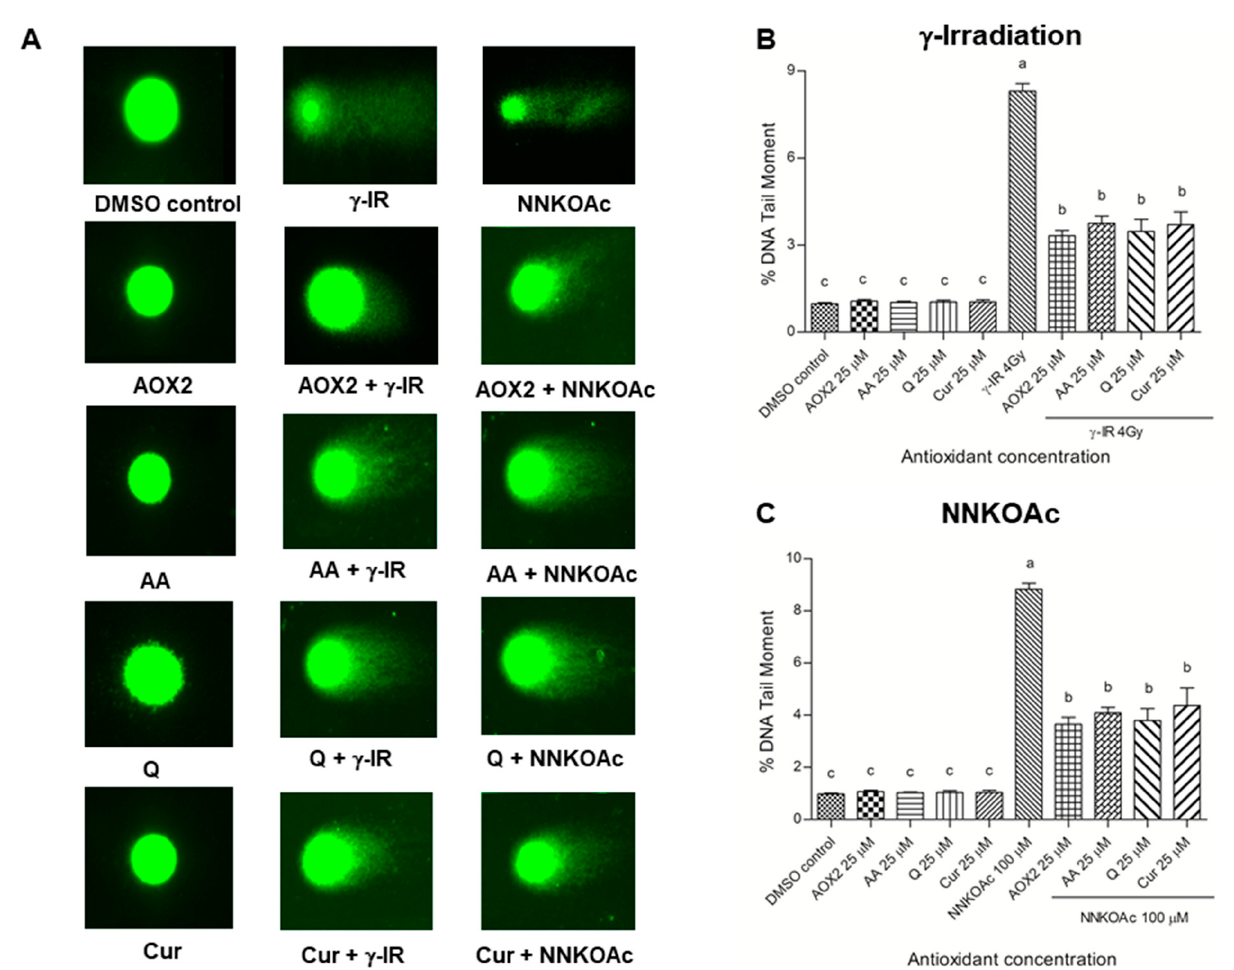
Figure 6. DNA tail damage in BEAS-2B cells that were exposed to γ -irradiation or carcinogen NNKOAc with or without pre-treatment of antioxidants. The cells were stained with CYGREEN ® dye and imaged by fluorescence microscopy ( A ). DNA single-strand break was reduced by pre- exposure to tested antioxidants in γ -irradiation ( B ) or carcinogen ( C ) induced BEAS-2B cells. DNA single-strand break was determined as % DNA tail moment measured by comet assay. Quantification was performed for at least 30 comets that were photographed using fluorescence microscopy. Experimental values are mean ± SD of three independent experiments in triplicate. One-way analysis of variance was performed with Tukey’s pairwise comparison. Means that share the same letter are not significantly different at p ≤ 0.05. Abbreviations: AOX2, dietary antioxidant formulation-2; AA, ascorbic acid; Q, quercetin; Cur, curcumin; DMSO, dimethyl sulfoxide; γ -IR, γ -irradiation.